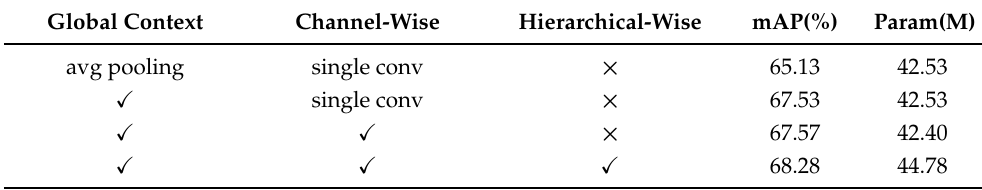
Table 6. Effectiveness of internal components of semantic alignment